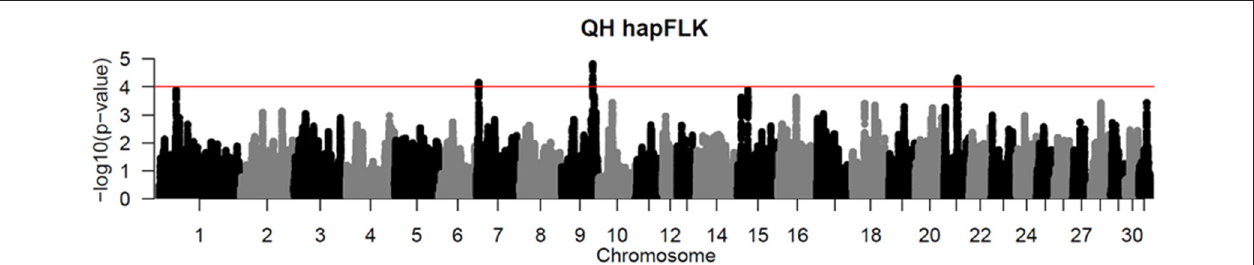
FIGURE 2 | Haplotype-based hapFLK results for all 6 QH subpopulations. Chromosome number and statistical significance ([–log 10 ] p -values) are plotted in the x and y axes, respectively. The genome-wide significance threshold corresponding to P < 0.0001 is shown as a horizontal red line.